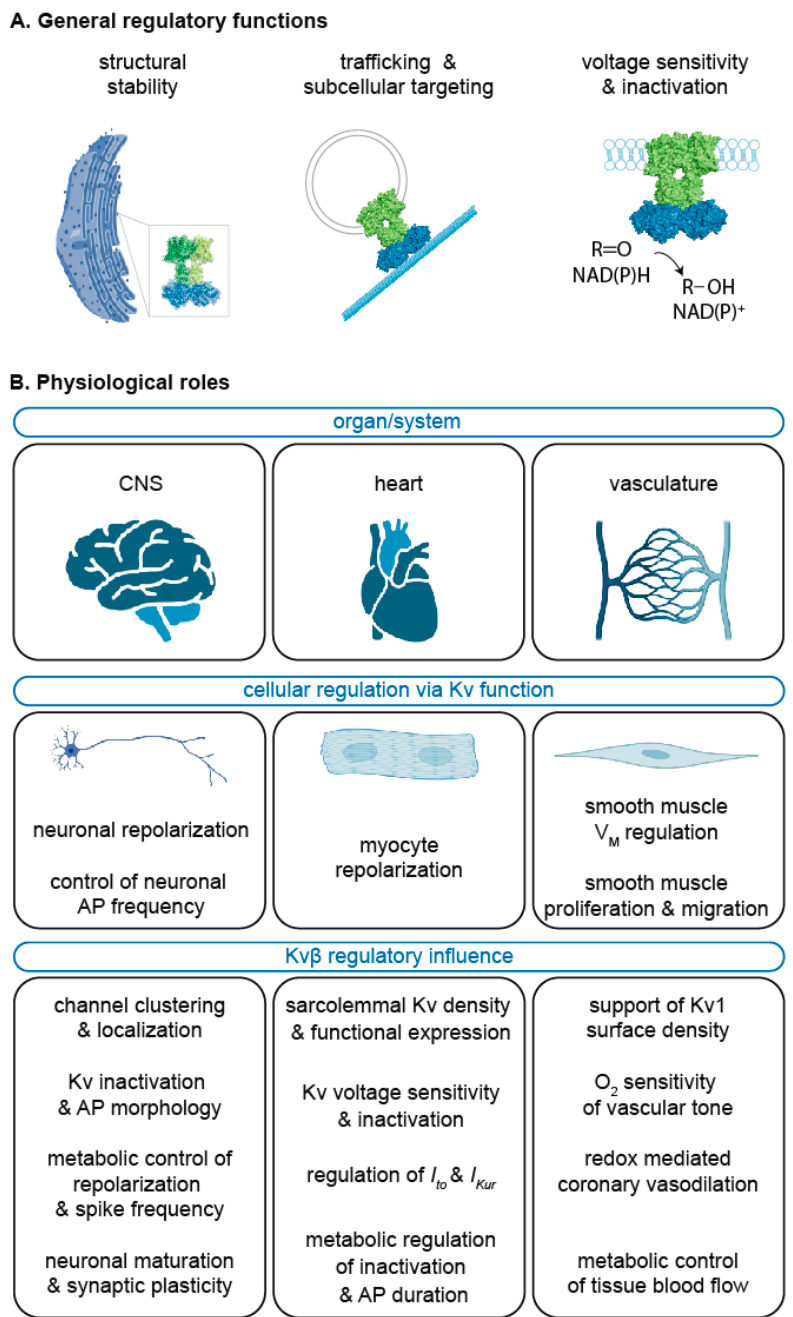
Figure 4. Summary of the Kv β functional roles. General regulatory features or Kv β ( A ) as discussed in Sections 2 and 3 and the key physiological roles for Kv β proteins in the central nervous system (CNS), heart, and vasculature ( B ) as discussed in Sections 4–6. Created with BioRender.com (accessed on 2 July 2022).